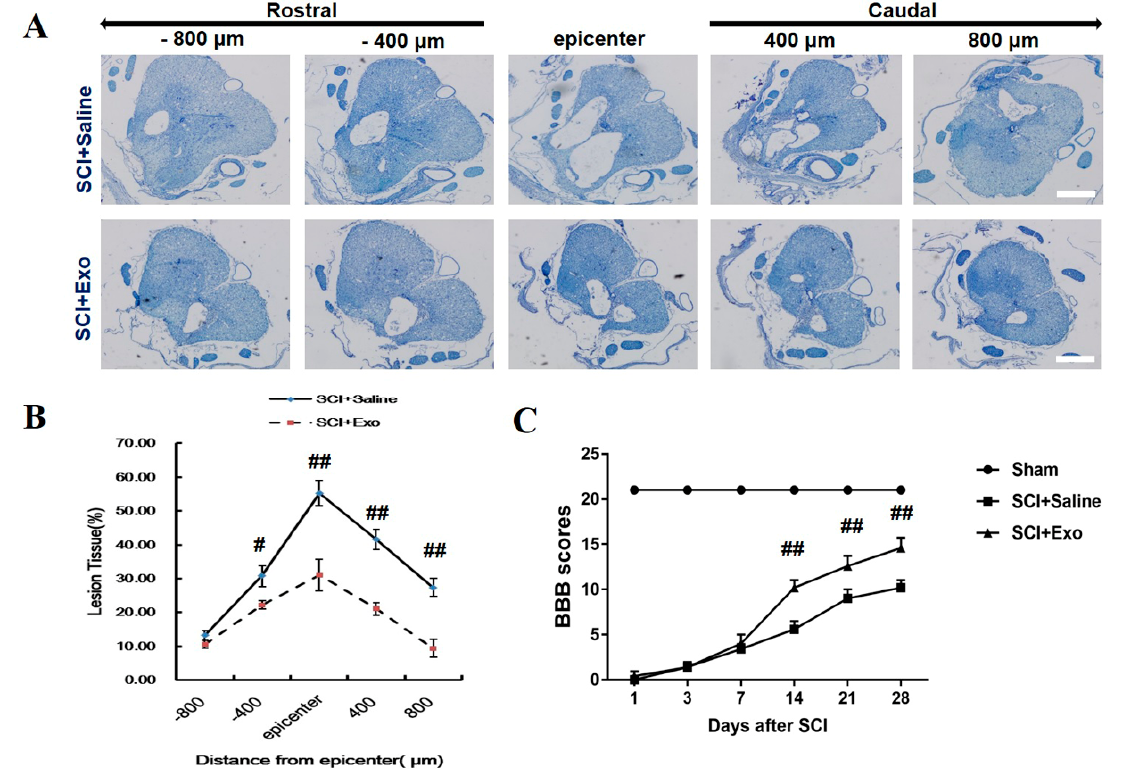
Figure 2. M2 macrophage exosomes attenuate TD and improve FR post-SCI. Representative cresyl violet staining of the SC lesion cavity ( A ). Quantification of the lesion cavity; the ratio presents as “lesion area/total area”, 800 µ m caudal and rostral to the epicenter, after 28 days of SCI ( B ). FR of rats was accessed by BBB scores and ranged from day 1 to day 28 ( C ). Mean ± SD. # p < 0.05 SCI + Exo versus PBS group, ## p < 0.01 SCI + Exo versus PBS group. n = 5 per group. Scale bar = 1 mm .